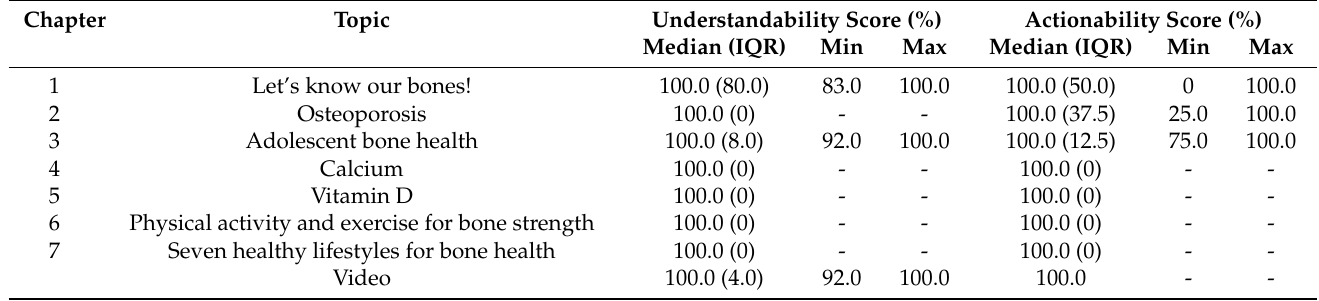
Table 6. Scores of understandability and actionability of the e-book for adolescent bone health and osteoporosis educational